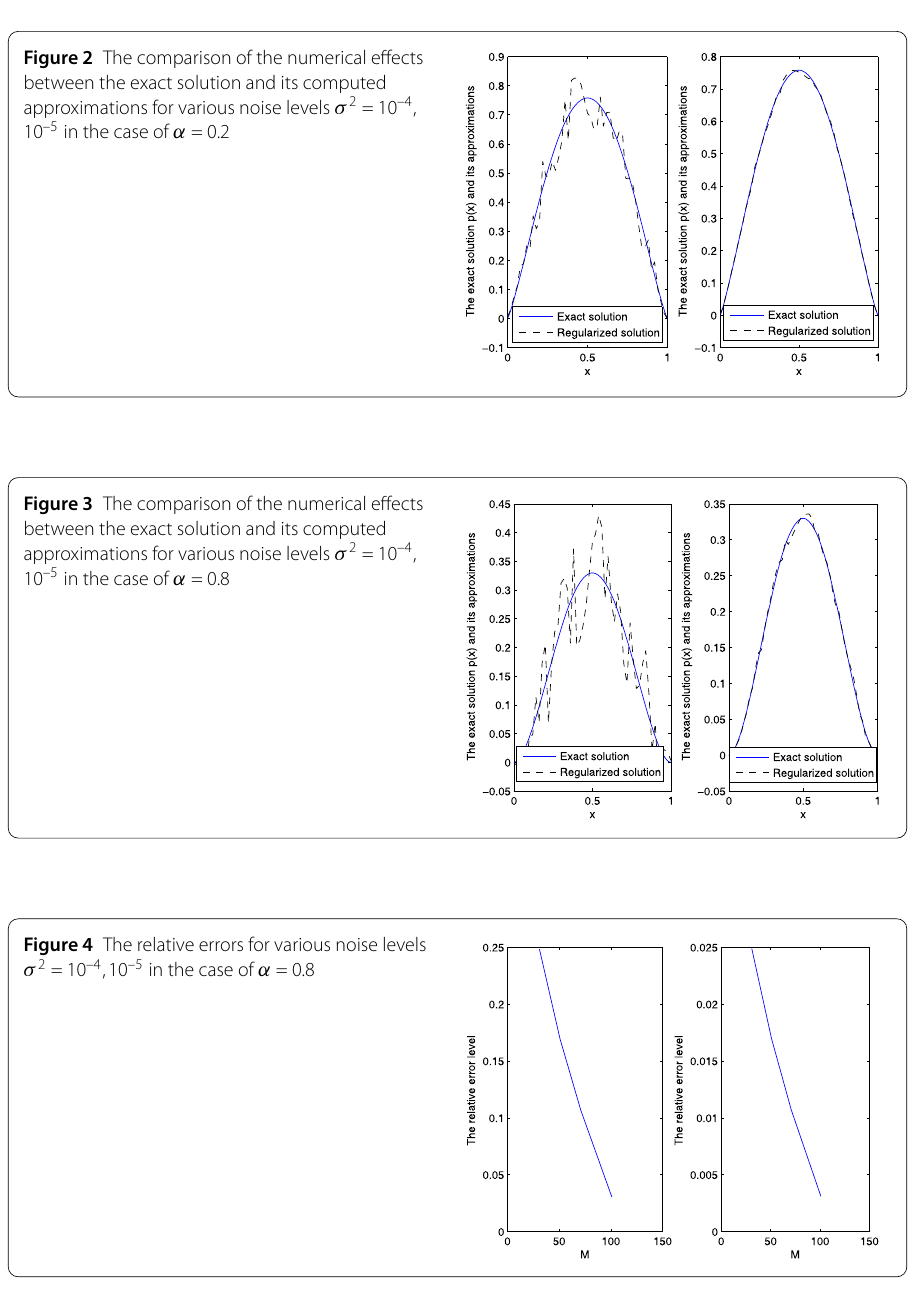
Figure 2 The comparison of the numerical effects between the exact solution and its computed approximations for various noise levels σ 2 = 10 –4 , 10 –5 in the case of α = 0.2